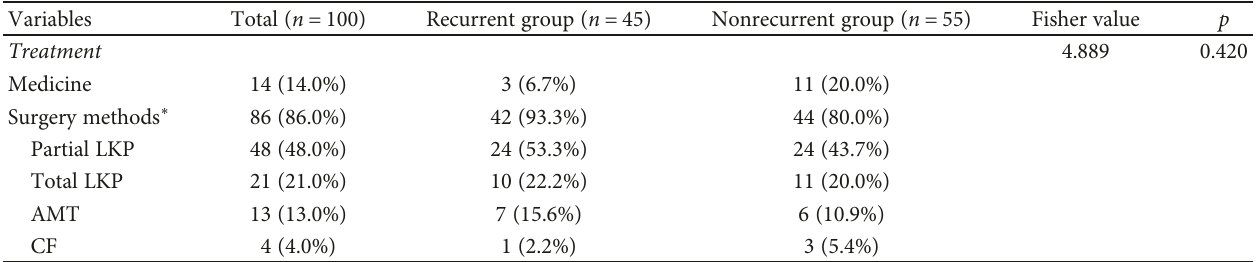
Table 3: Clinical treatment of a ff ected